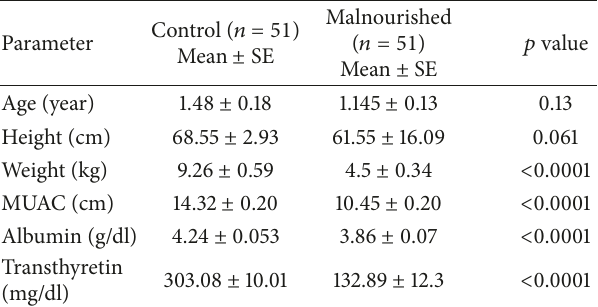
Table 1: Comparison of mean values of anthropometric and biochemical measurement between control and study